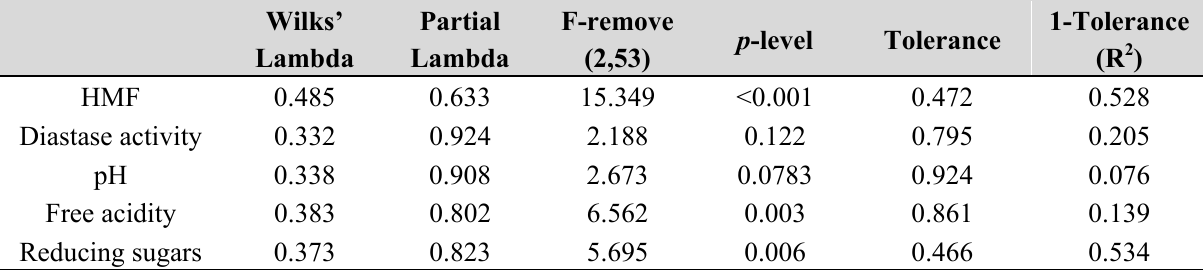
Table 4. Results of stepwise discriminant analysis (SDA) of physicochemical parameters in the three harvests of PDO